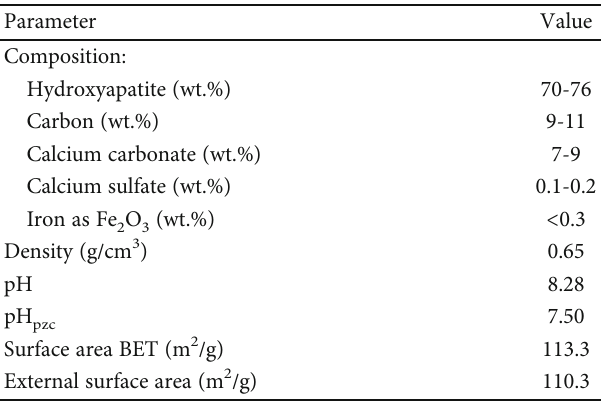
Table 1: Physicochemical properties of bone char used for the separation of bioalcohols from aqueous